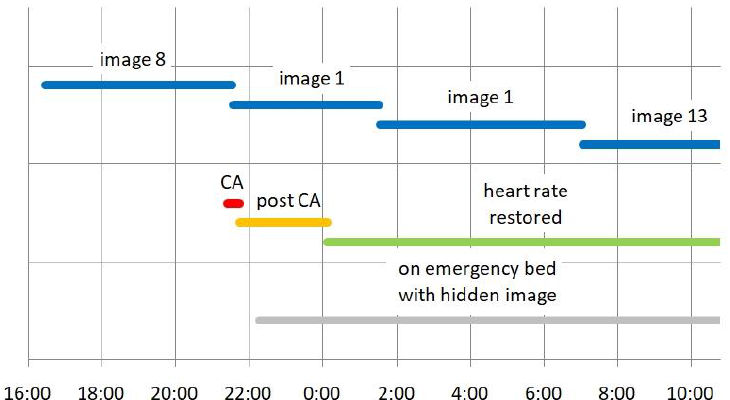
Figure 2. Presentation of randomized pictures visible only from above. Case K (№ 83) suffered CA (red line) in hospital late in the evening. She was rushed to the emergency unit and installed on the bed (gray line) with image presentation to the ceiling (not noticeable from the bed). During the post-CA period (orange line), heart rate in all likelihood still did not support regular brain function. Ordinary rate (green line) was restored more than 2 h after CA. Image presentation (blue lines) had switched during the acute CA from image 8 to image 1 over the empty bed. The next switch occurred 4 h later (with the patient present) from image 1 to image 1 (accidently the same image once more), and another switch 5½ h later from image 1 to image 13. During these latter two periods, brain function had returned to nearly normal and the patient was sleeping. None of the presented images came close to the impression reported later by the patient.